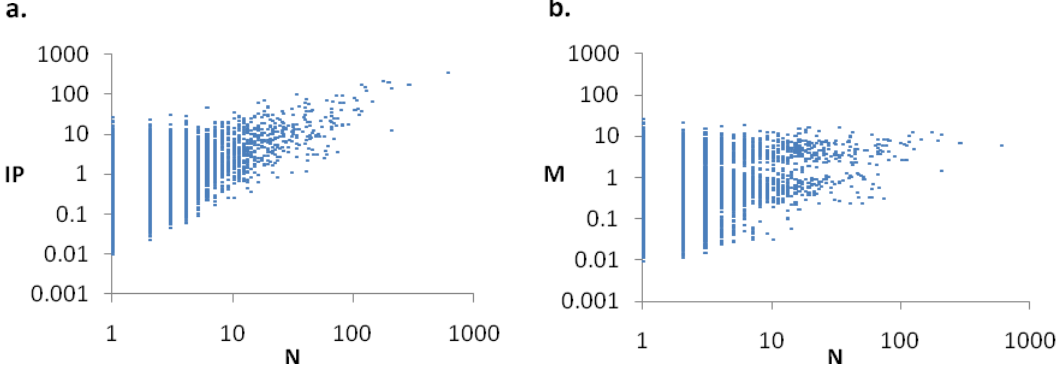
Figure 5: Comparison of IP scores vs number co-citations N (a); and the M scores vs N for all 10,777 protein-stress pairs (b). For N=5 the IP varies from 0.1 – 13 and the M from 0.05 –